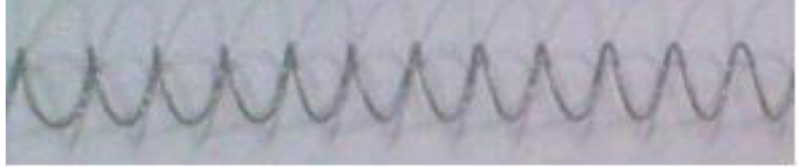
Figure 11: Wire coil insert